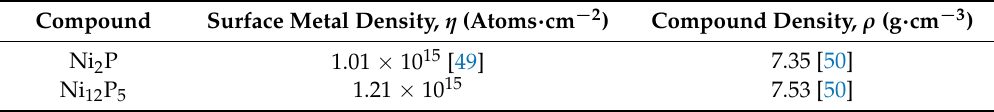
Table 3. Surface metal density and bulk density of nickel and nickel phosphide.